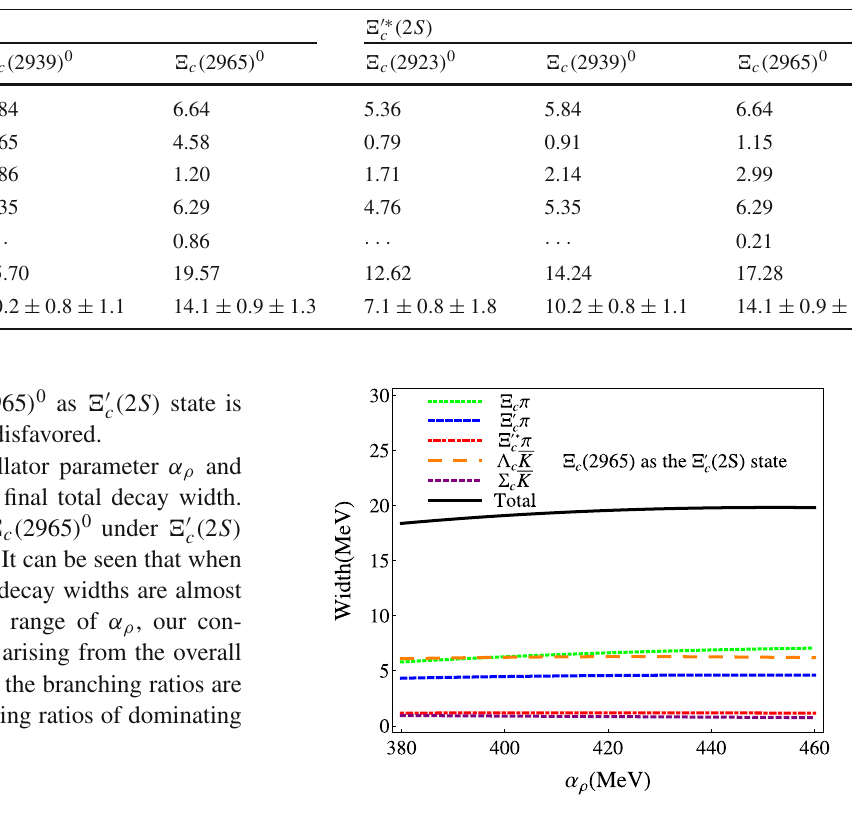
Fig. 1 The dependence on the harmonic oscillator parameter α ρ of the